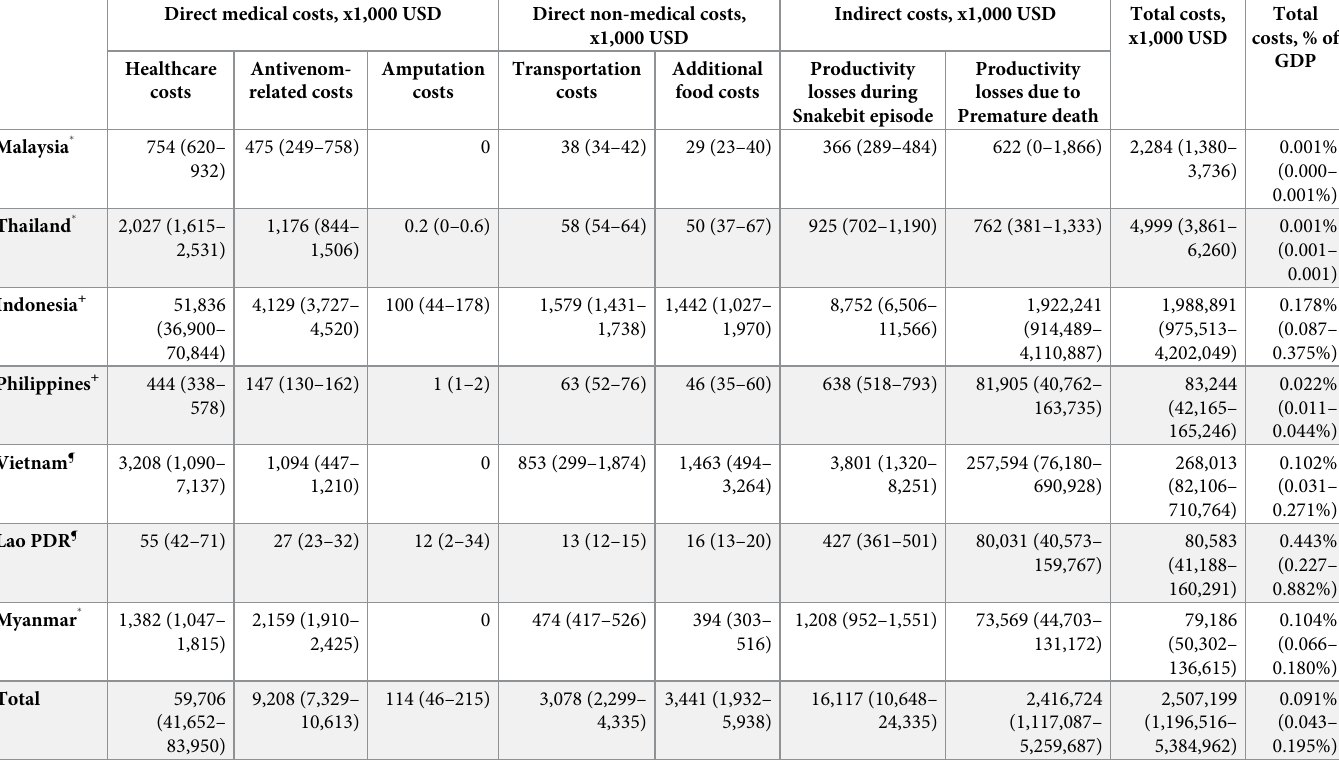
Table 2. Estimated annual economic burden (x1,000 USD) of snakebite in ASEAN countries. Direct medical costs, x1,000